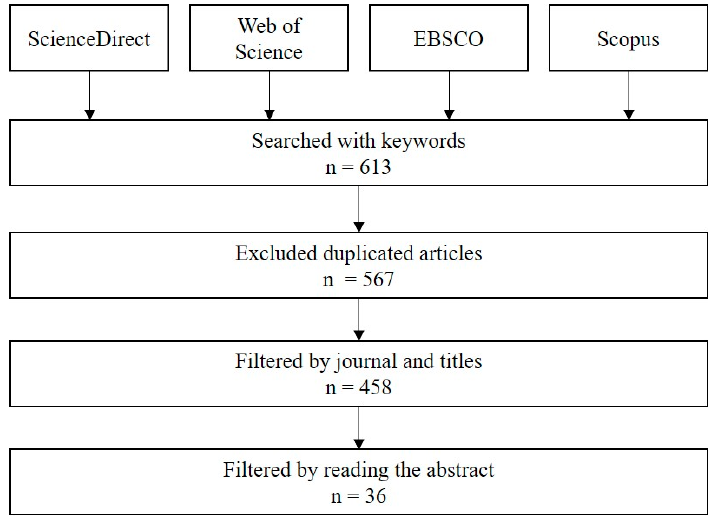
Figure 1. Flow diagram of selection and screening process.